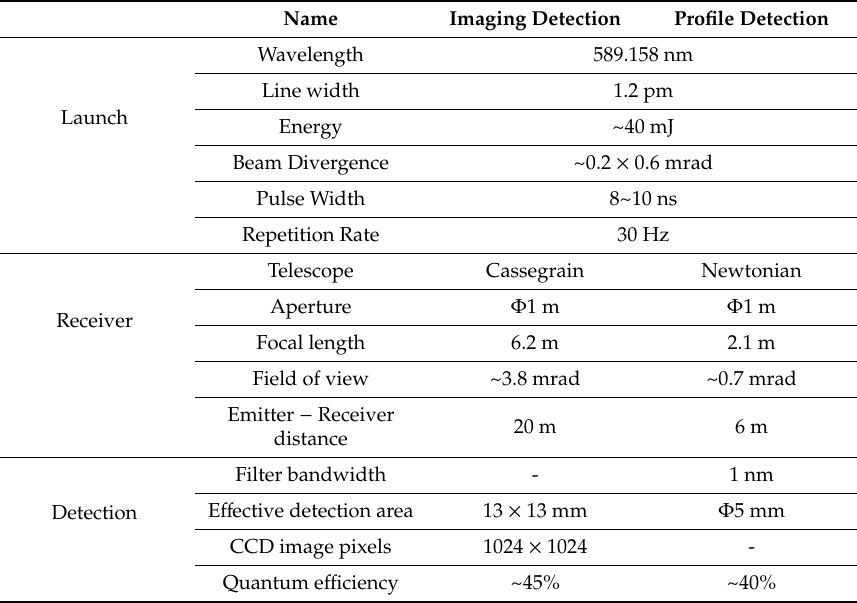
Table 1. Main technical specifications of the Na imager and the Na